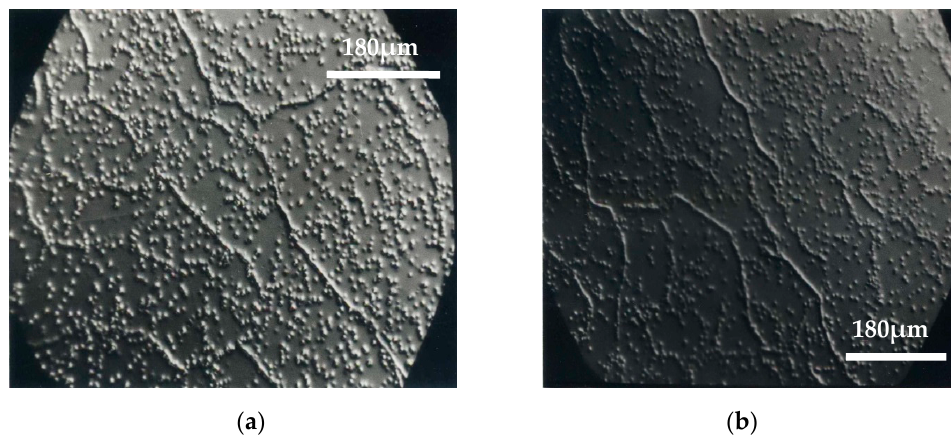
Figure 2. ( a ) Cd 0.96 Zn 0.04 Te, v = 3.32 mm/h, δ = 6.3 × 10 5 cm − 2 , φ = 19 ″ ; ( b ) Cd 0.96 Zn 0.04 Te, v = 1.66 mm/h, δ = 7.6 × 10 5 cm − 2 , φ = 25 ″ .